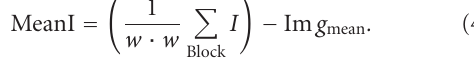
The mean information MeanI for each block is given